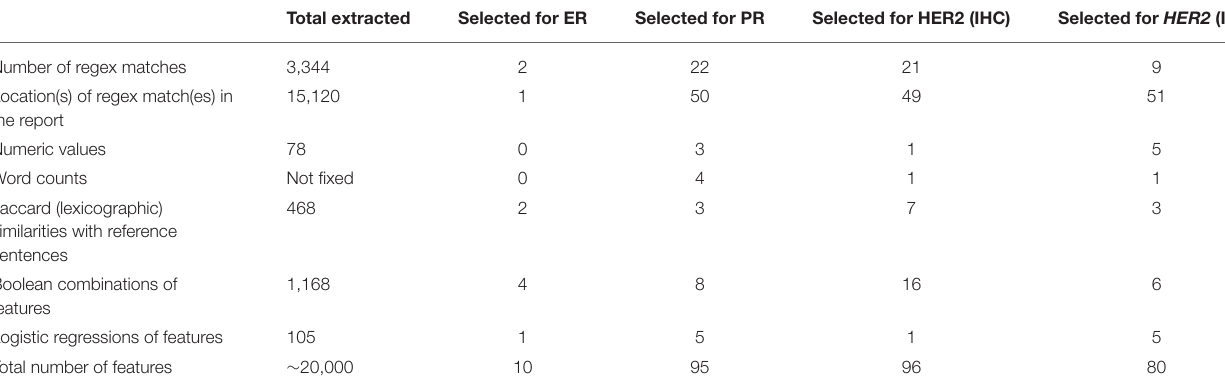
TABLE 1 | Numbers and types of selected features for each of the four classification tasks. Total extracted Selected for ER